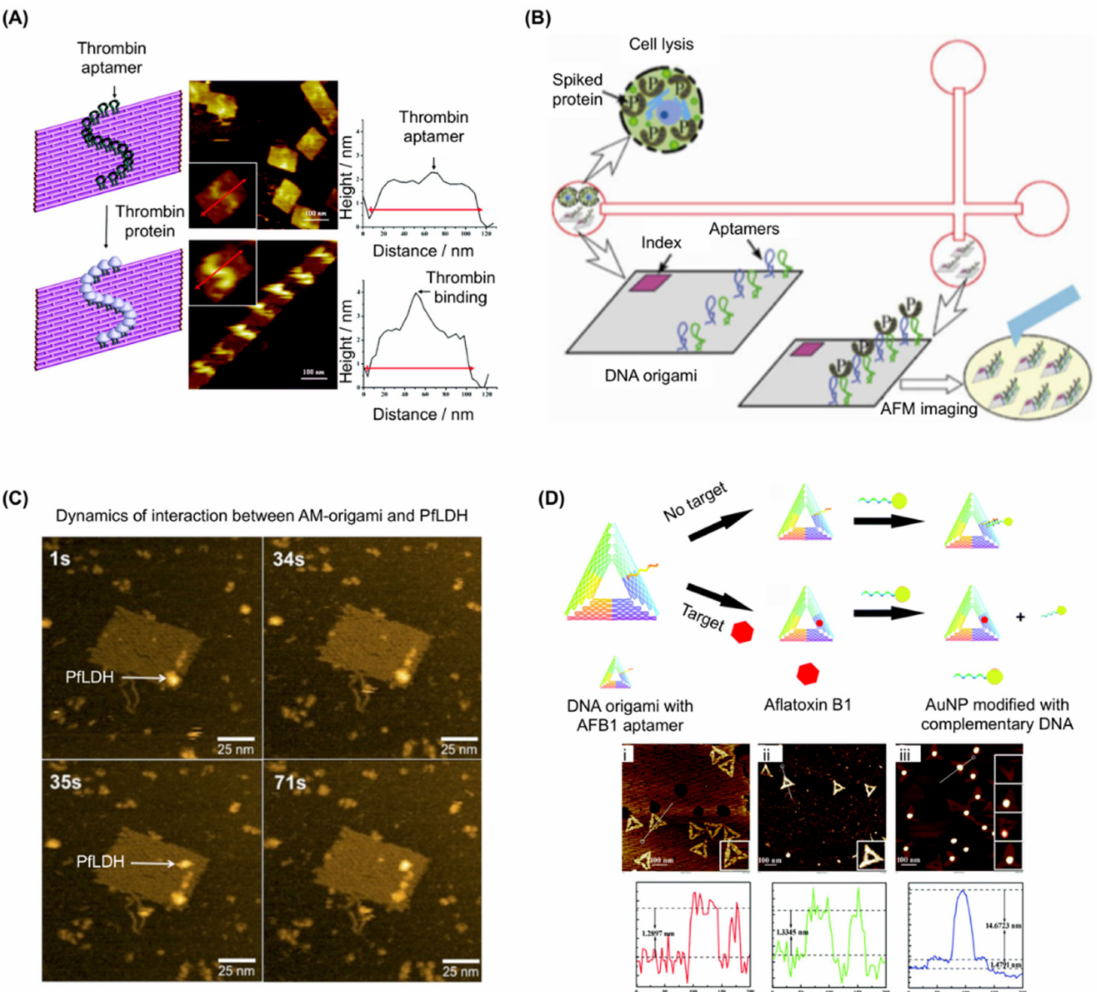
Figure 2. Examples of aptamer use in target immobilization on DNA origami. ( A ) ( left ) Schematic showing an S-shaped pattern of thrombin templated on DNA origami. Grey balls represent thrombin proteins. ( middle ) Images corresponding to the arrays shown on the left, with enlarged images (inset); ( right ) line cross-section analysis of the atomic force microscopy (AFM) images show an increase in the height at the sites of protein binding. Adapted with permission from Chhabra et al. [18]. Copyright (2007) American Chemical Society. ( B ) Schematic for the stacking, separation, and identification of DNA origami and its protein binding using isotachophoresis (ITP) in a cross-channel microfluidic chip fabricated in fused silica. DNA origami with bivalent aptamers was assembled by replacing individual staple strands. Thrombin was used as the target analyte to provide functional validation. After incubating origami in thrombin-spiked cell lysate, separation was performed by on-chip ITP and was verified by direct visualization with AFM. Adapted with permission from Mei et al., Nano Res., 2013 [54]. ( C ) High speed (HS)-AFM images showing the dynamics of the interaction between AM-origami and Plasmodium falciparum lactate dehydrogenase (PfLDH). At 1 s, a single AM-origami is visible with one PfLDH (indicated by a white arrow) attached to the aptamer-modified region. At 35 s, a second PfLDH (indicated by a white arrow) binds to the region and both proteins remain in place beyond 71 s. Adapted from Godonoga et al. [57]. ( D ) ( top ) Schematic illustration of the analytical principle of the aptamer-tagged DNA origami/complementary ssDNA-AuNPs system for detecting aflatoxin B1 (AFB1); ( bottom ) AFM images with section plots of aptamer-tagged triangular DNA origami nanostructures before and after binding. (i) Aptamer-tagged triangular DNA origami; (ii) aptamer-tagged triangular DNA origami after binding with AFB1; (iii) aptamer-tagged triangular DNA origami after hybridization with the AuNP-conjugated ssDNA. From Lu et al., Chem. Commun., 2017 [58]—Reproduced by the permission of The Royal Society of Chemistry. AuNP: Gold